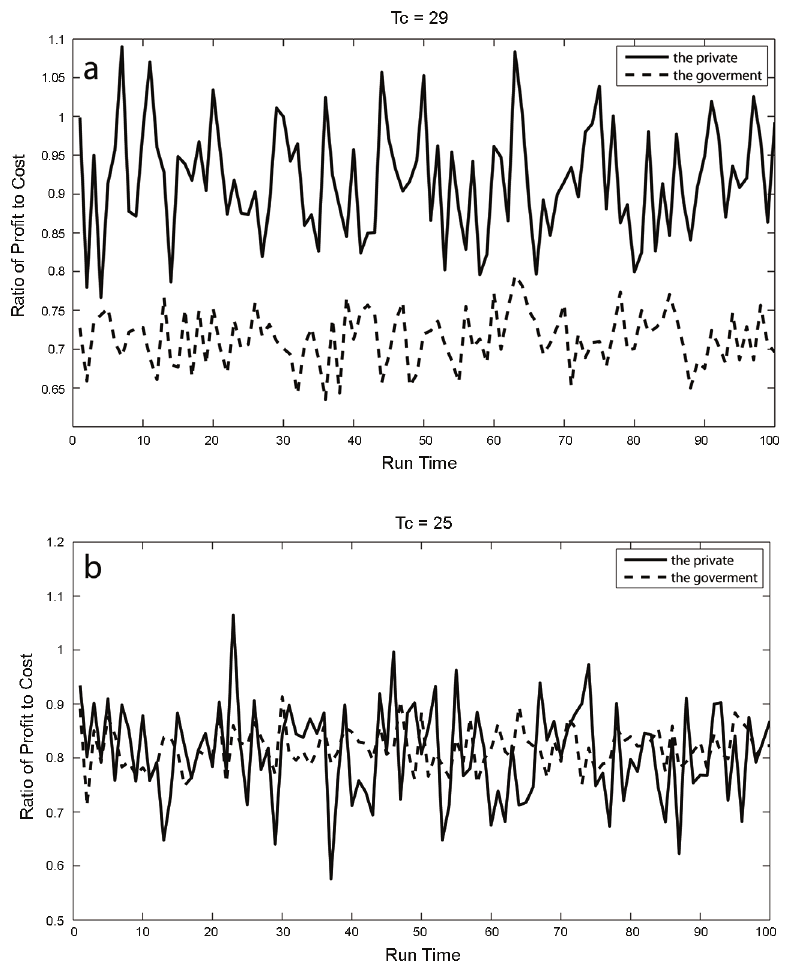
Figure 6. The difference between the both sides’ ratio of profit to cost with the fairness and without the fairness